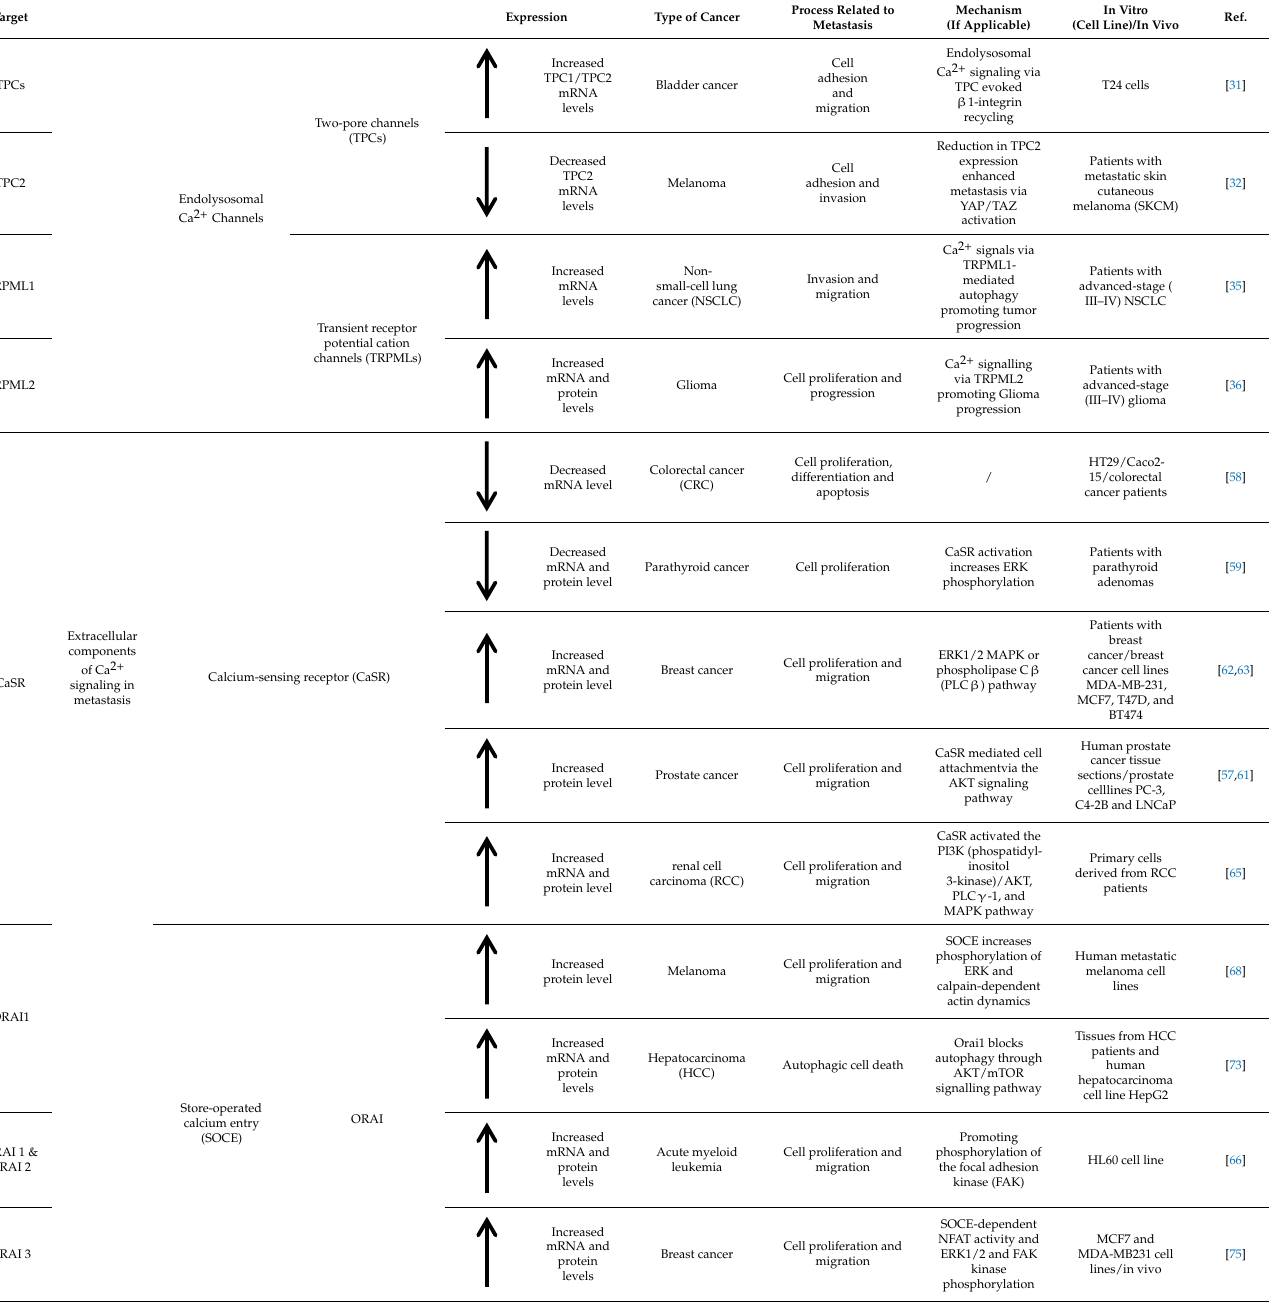
Table 1. Some experimental evidence supporting Ca +2 signalling-mediated cancer metastasis.